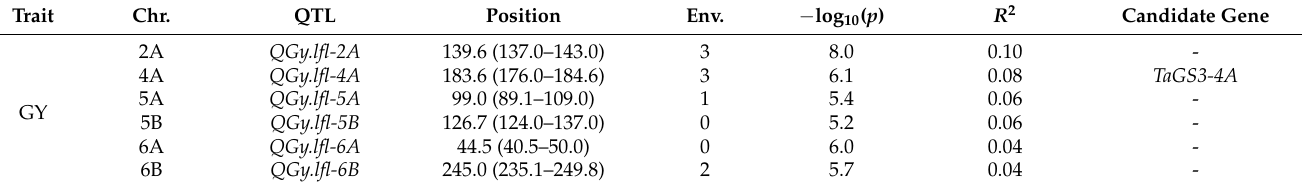
Table 3. Characterization of quantitative trait loci identified by composite interval mapping: chromo- some (Chr.), QTL identifier, position on the genetic map with the support interval in centimorgans, number of environments (Env.) in which the QTL was observed, − log 10 ( p ) value, explained pheno- typic variance ( R 2 ), and candidate gene. All shown QTL were detected across